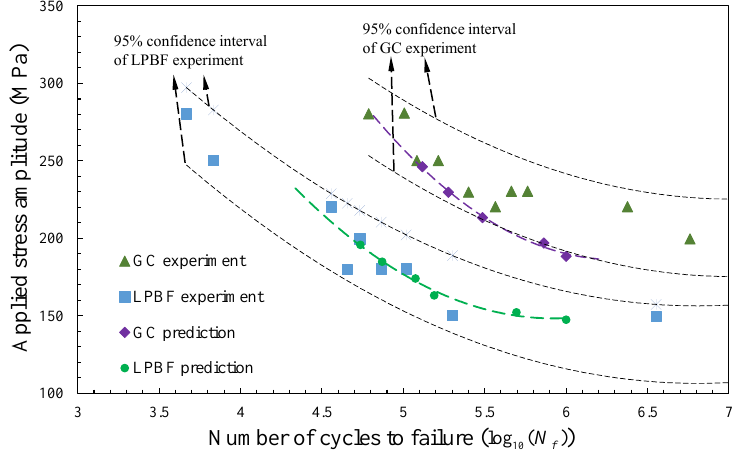
Figure 12. Comparison of predicted S–N curves and traditional fatigue testing results adapted from [4] for both Gravity Casting (GC) and Laser-based Powder Bed Fusion (LPBF) AlSi10Mg